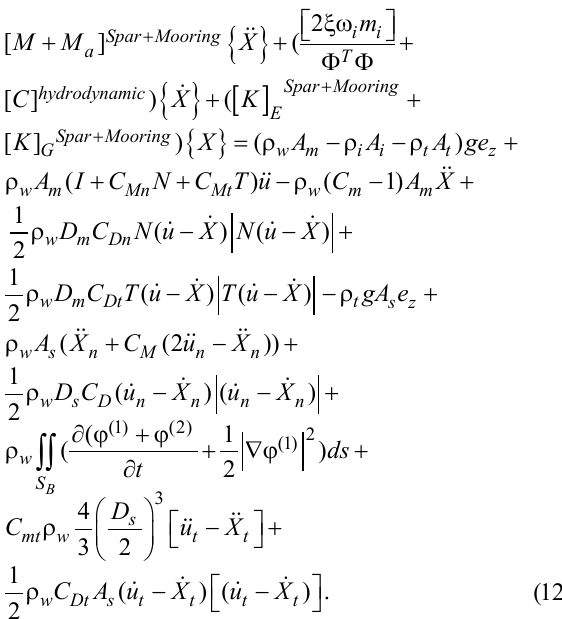
A rigid beam element is considered to model the cy